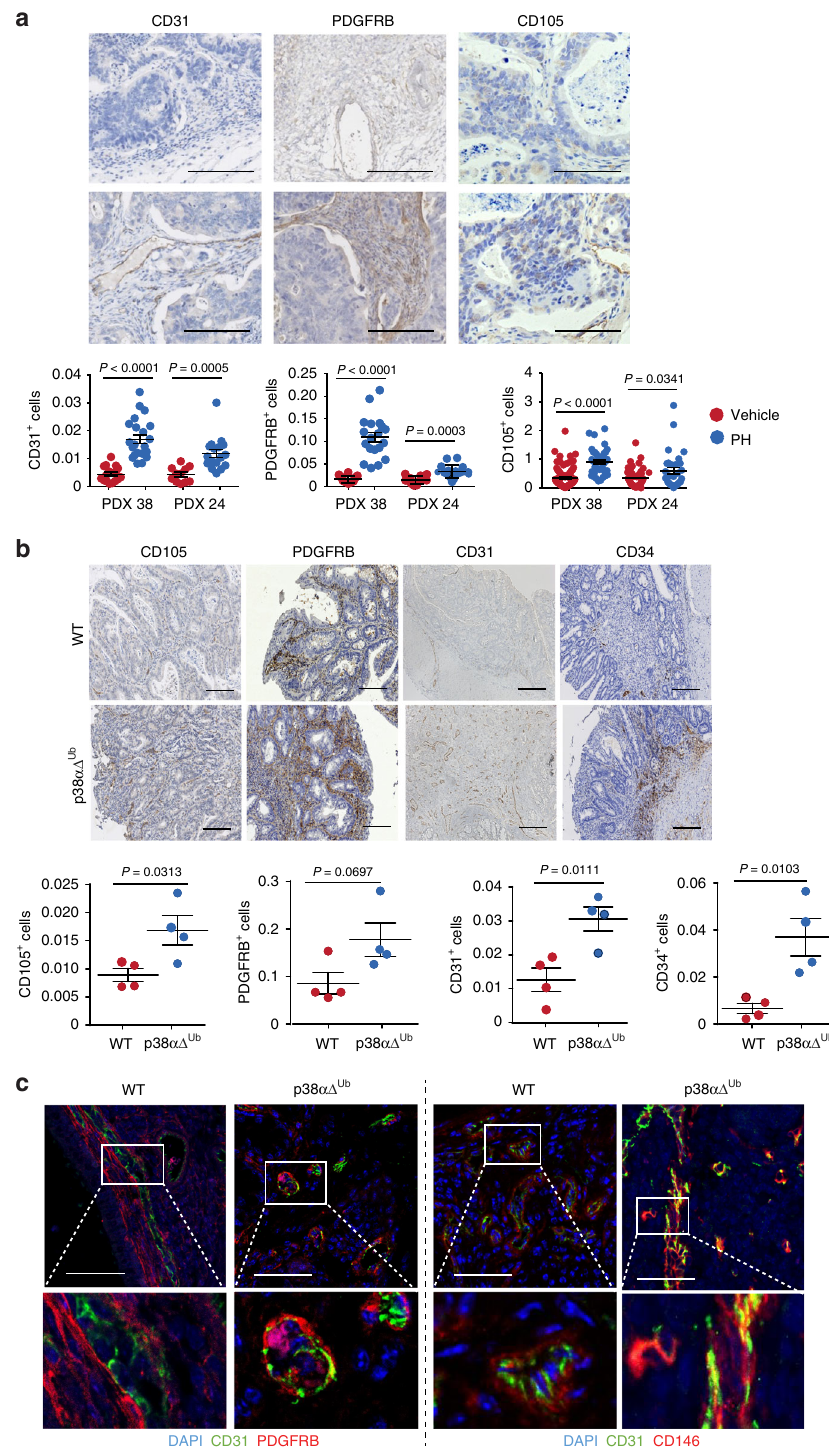
Fig. 1 Pharmacological inhibition of p38 α induces angiogenesis in human and mouse colon tumors. a Immunostaining analysis of two different human colon PDXs that were treated with the p38 α inhibitor PH797804 (PH) or vehicle. The percentages of CD31 + , CD105 + , and PDGFRB + cells among the total number of cells per tumor area were determined using ImageJ on pictures from colon tumors. n ≥ 4 images for each condition. Bars, 100 μ m. Data represent mean ± SEM ( n = 4 tumors). b Immunostaining analysis of colon tumors induced by AOM/DSS in WT or p38 αΔ Ub mice. The percentages of CD31 + , CD105 + , CD34 + , and PDGFRB + cells among the total number of cells per tumor area were determined using ImageJ on pictures from three colon tumors for each condition. Bars, 100 μ m. Data represent mean ± SEM ( n = 4 mice). c Colon tumors induced by AOM/DSS in WT and p38 αΔ Ub mice were stained with DAPI (blue) and immunostained for the endothelial marker CD31 (green) and the perivascular markers PDGFRB or CD146 (red). Bars, 100 μ m. The lower panels show higher magni fi cations of the indicated